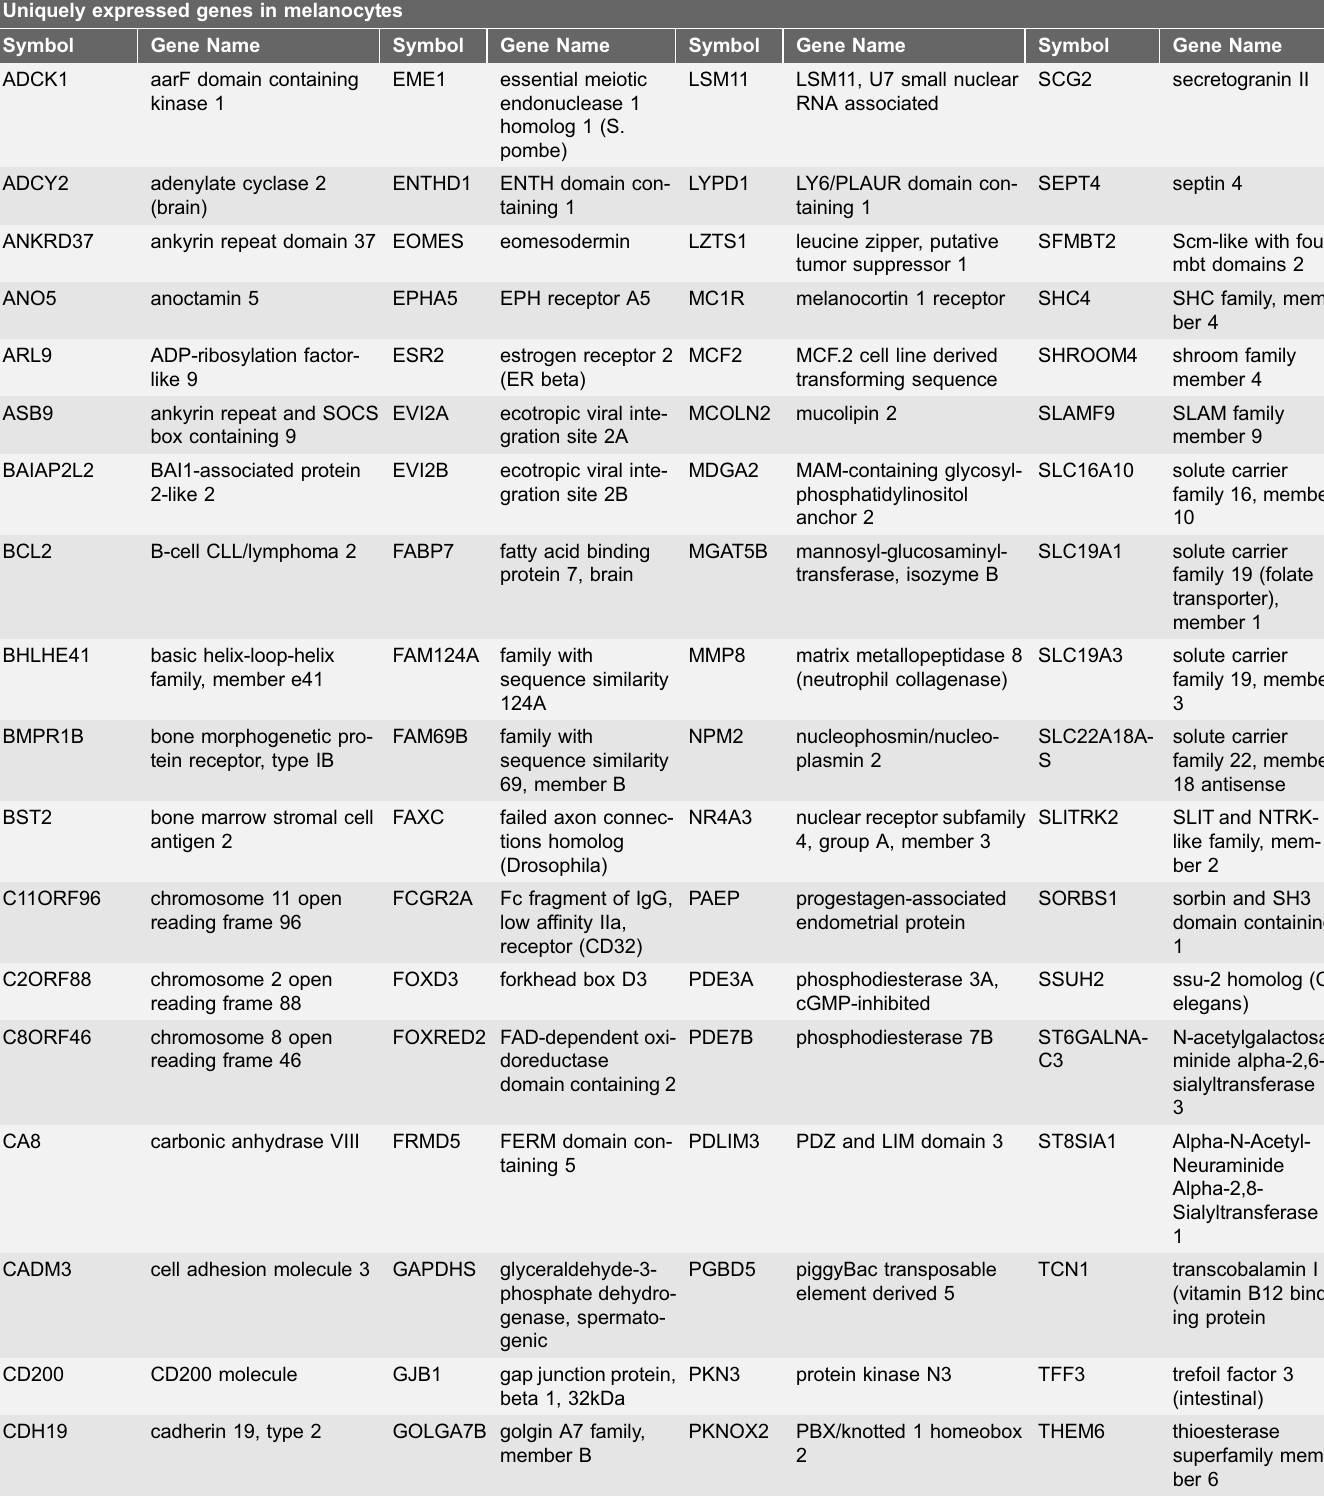
Table 2. Uniquely expressed genes in MC. Uniquely expressed genes in